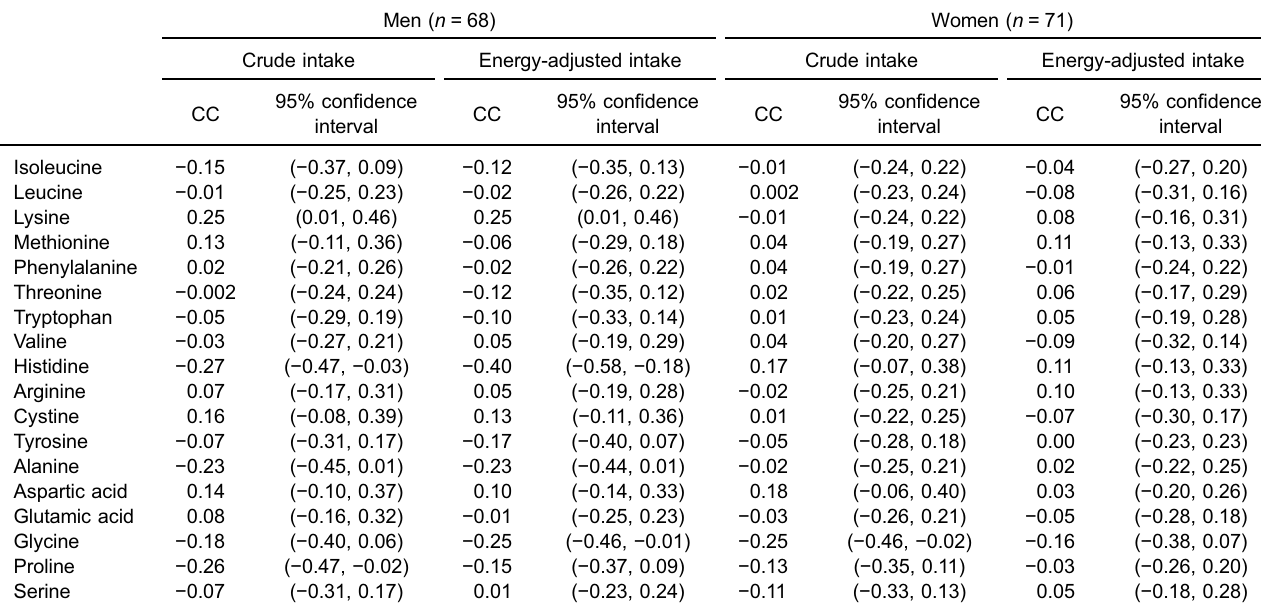
Table 4. Spearman rank correlation coef fi cients of amino acid intake from dietary records and plasma amino acid